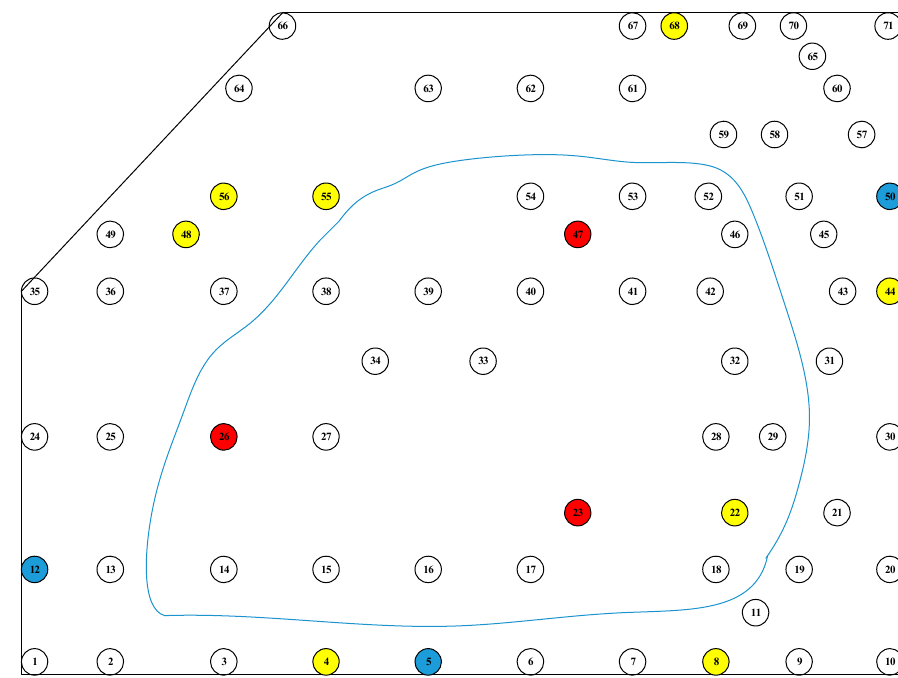
Figure 12. The absolute value of the absolute error of the trunk is greater than the position distribution of 2 cm. Red represents the interval of 1.0–1.1 m, blue represents the interval of 1.1–1.2 m, and yellow represents the interval of 1.2–1.4 m.